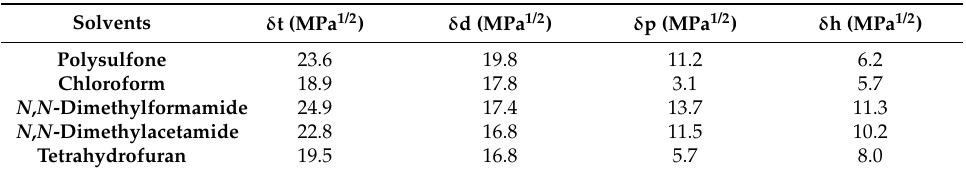
Table 1. Shortlist of Hansen Solubility Parameter (HSP) parameters of polysulfone (PSU) and possible compatible solvents [24].